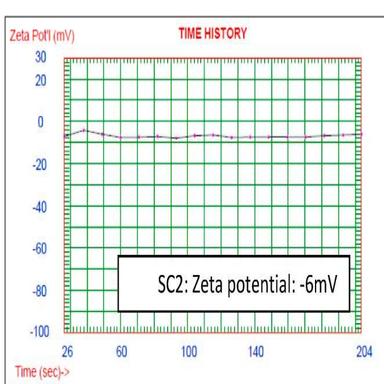
Zeta potential of SiO2@C nanocomposites.